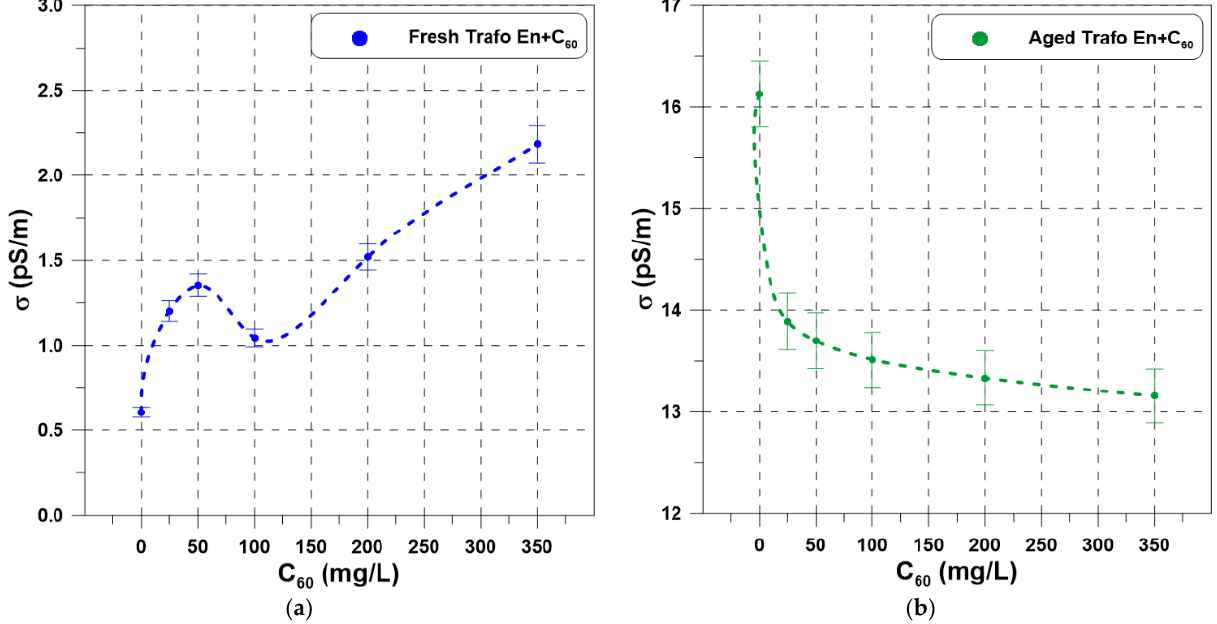
Figure 2. Conductivity of ( a ) fresh and ( b ) aged Trafo En mineral oil versus concentration of C 60 .